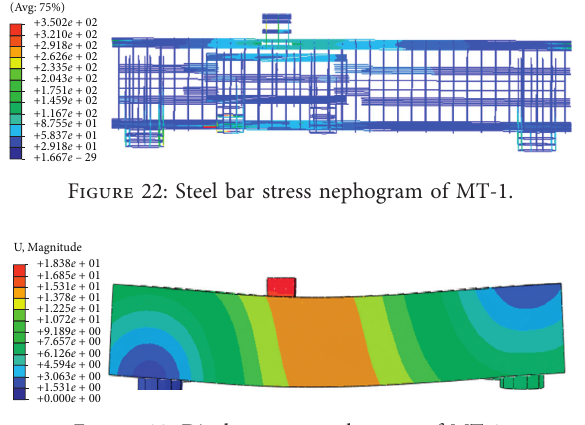
Figure 23: Displacement nephogram of MT-2.